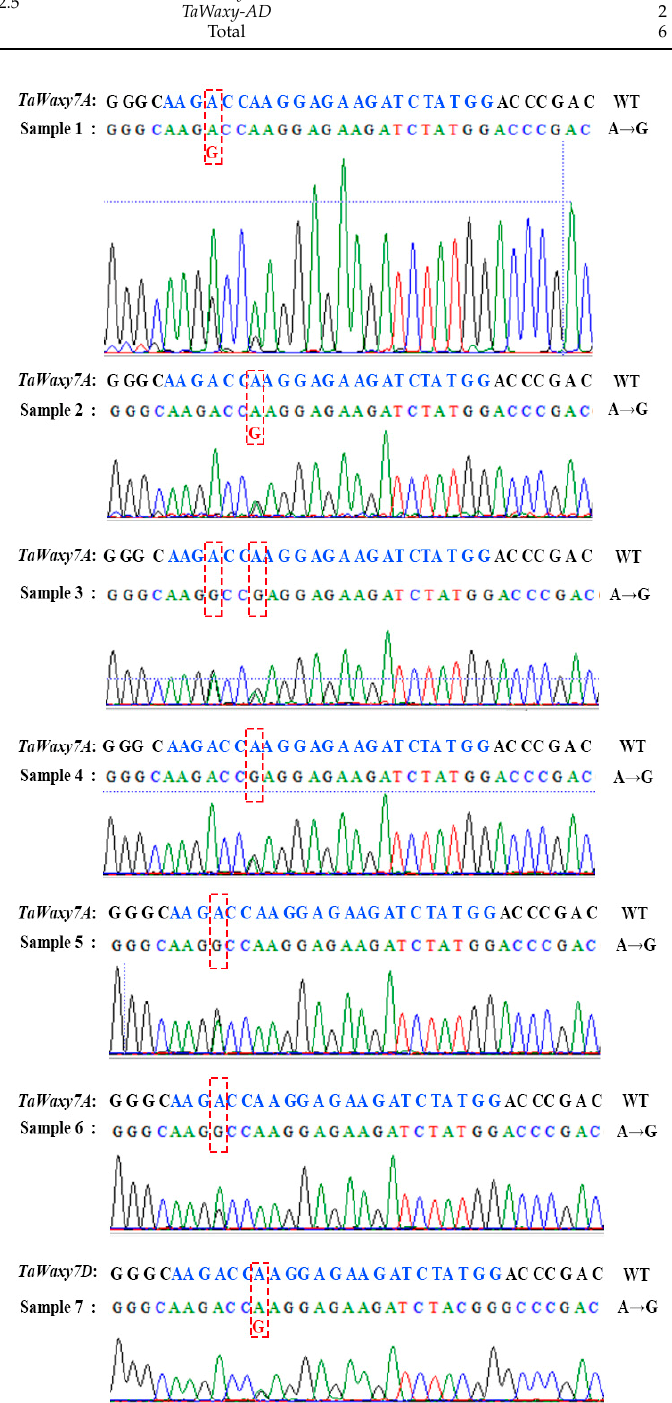
Figure 5. The sequencing results of base editing for the TaWaxy gene mutants. Sample 1: the mutants from the control group. Samples 2 – 7: the mutants from the nicotinamide treatment group.